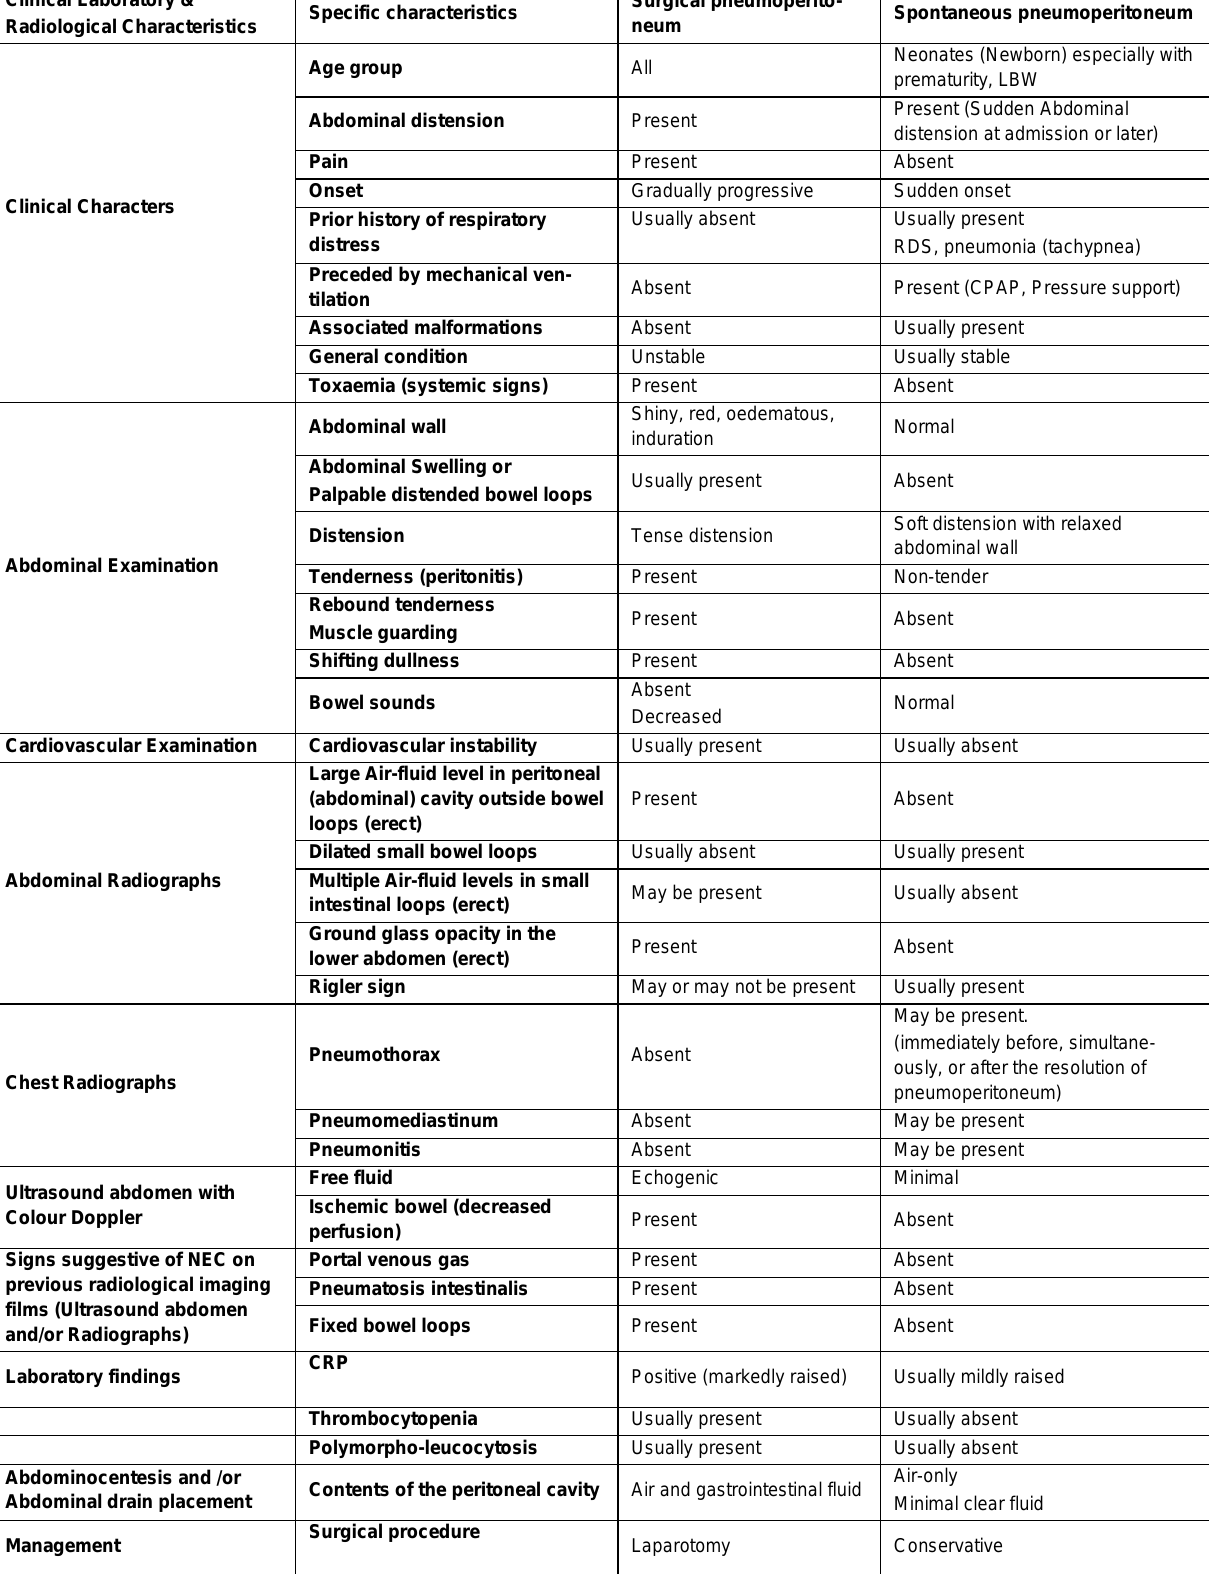
Table 2: Differences between spontaneous pneumoperitoneum and pneumoperitoneum due to bowel perforation (surgical